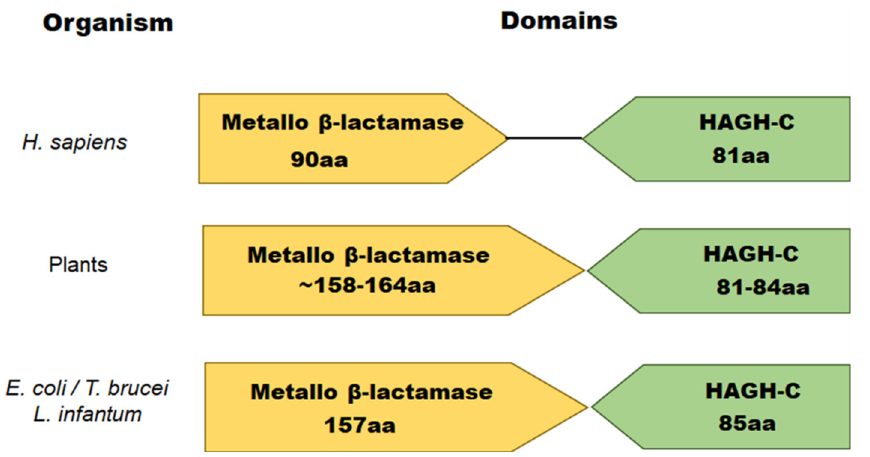
Figure 2. Schematic representation of the domains found in living systems for Glo2. Glo2 features a metallo- β -lactamase domain required for the catalytic activity and a hydroxyacylglutathione hydrolase C-terminus (HAGH-C) that represents the substrate-binding site. The length of these domains varies among different species and is indicated below each domain.